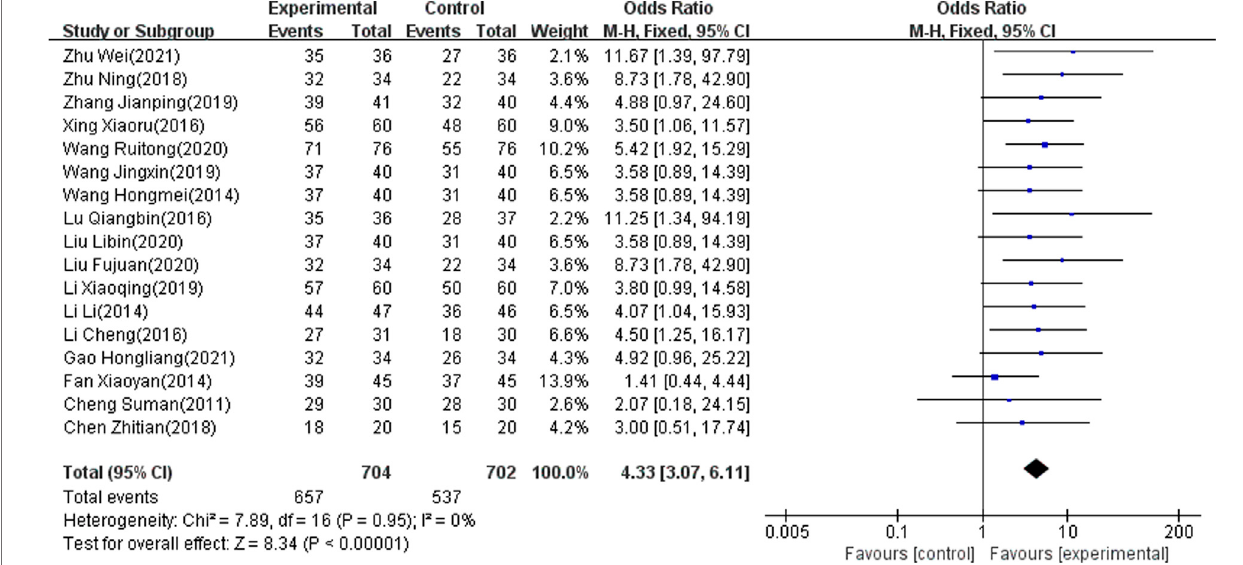
FIGURE 5 | Forest plot of total effect rate.